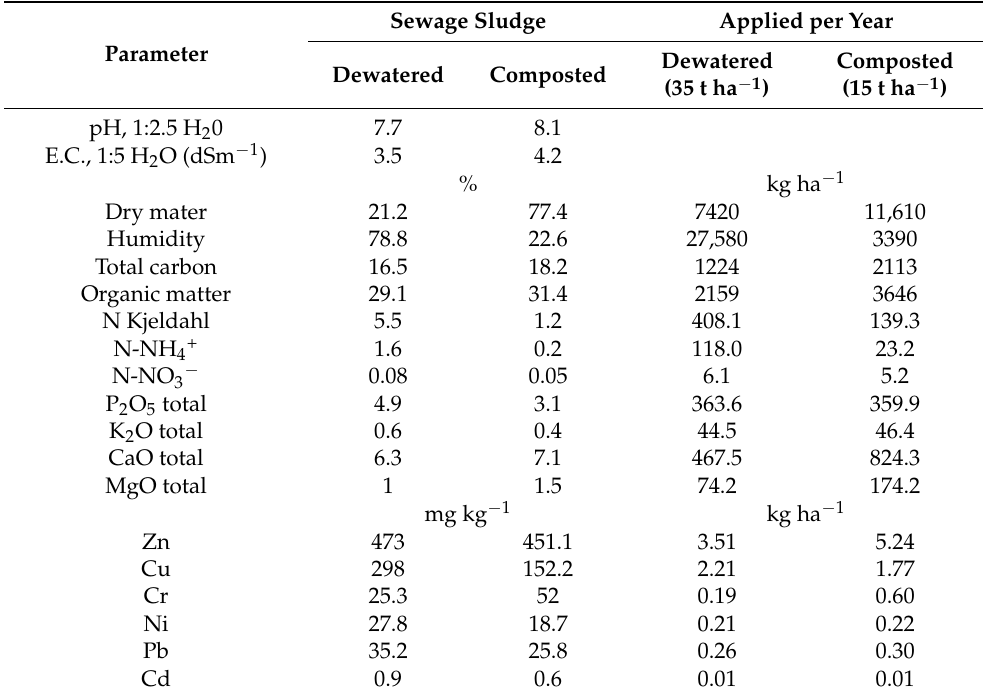
Table 1. Characteristics of dewatered sludge and composted sludge used as organic fertilization (dry